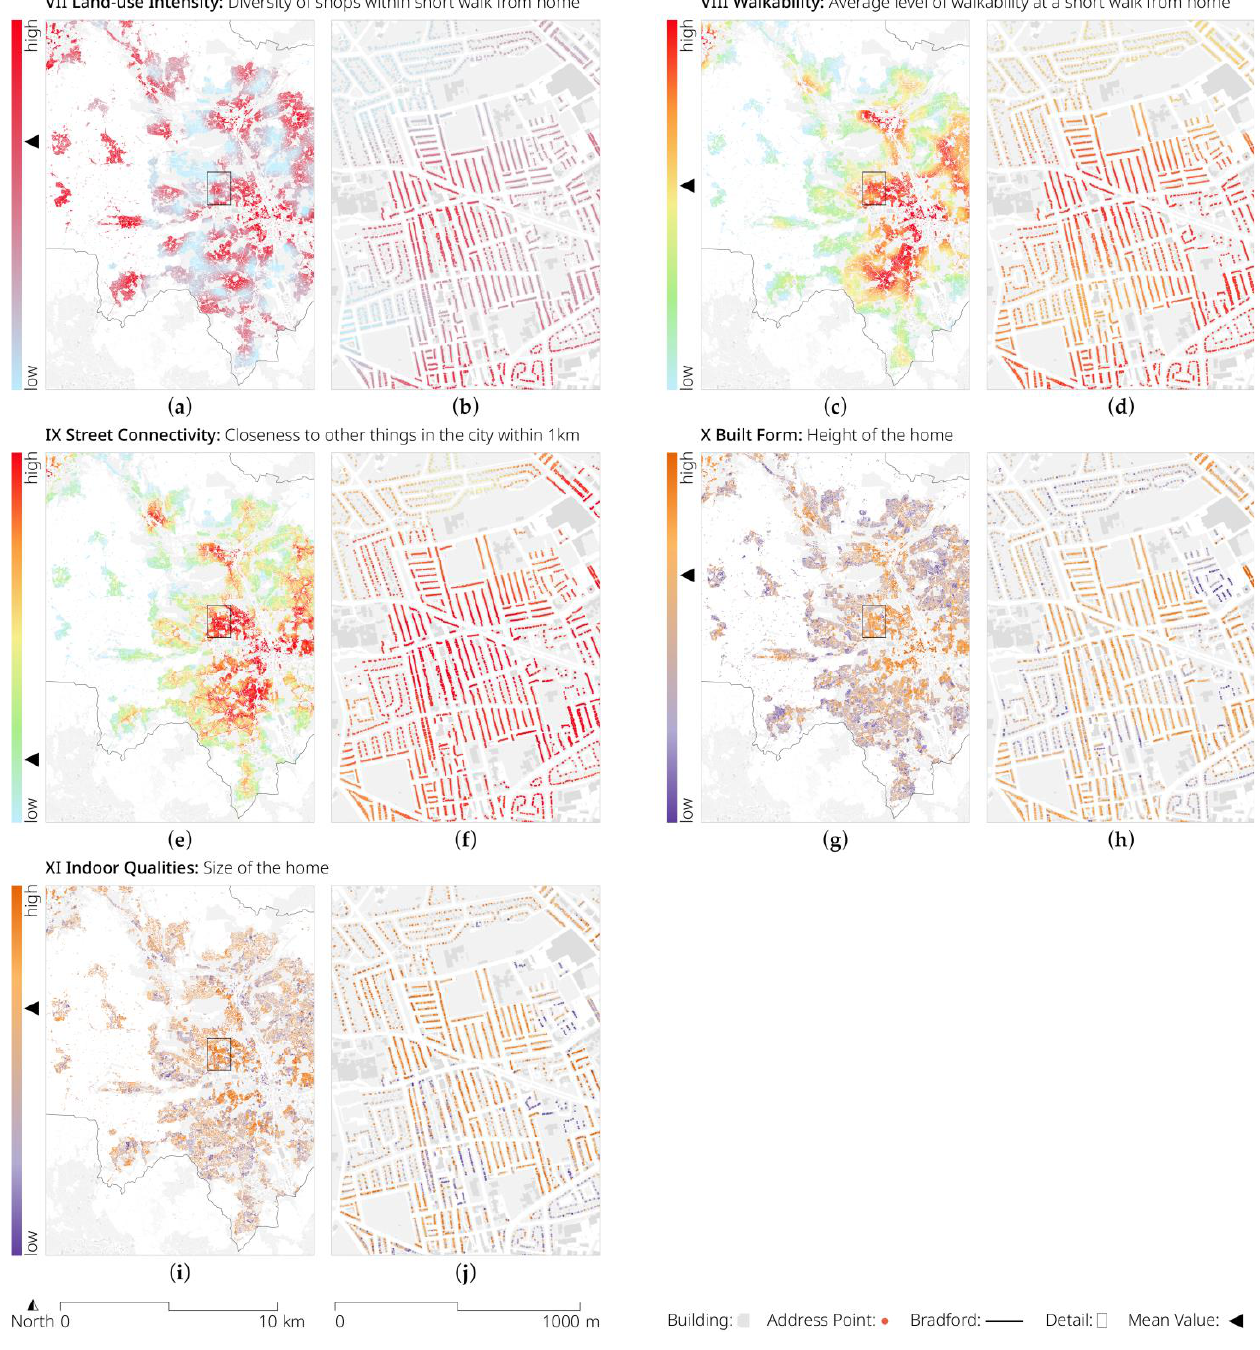
Figure 6. Visualisation of the selection of exemplary EIs (IX – XI, see Table 2 for details) for the entire metropolitan district of Bradford and a detailed zoom-in on the Toller ward. EIs include: ( a,b ) diversity of shops; ( c,d ) average level of walkability; ( e,f ) closeness to other things in the city; ( g,h ) height of the home; and ( i,j ) size of the home. © OS and Crown copyright 2022.